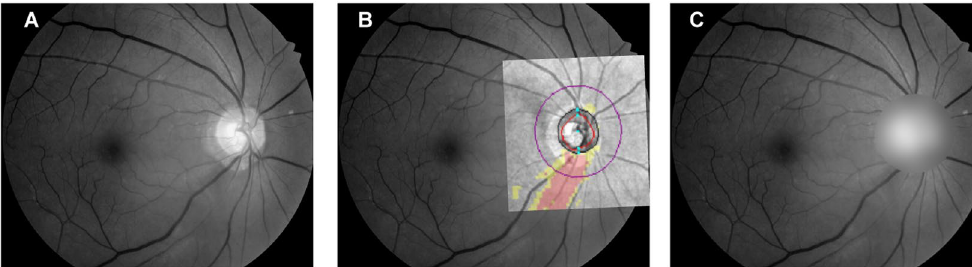
Figure 7. Example of peripapillary area masking on red-free RNFL photograph (RNFLP) (identical case to Fig. 5A). (A) Digital RNFLP. (B) RNFL deviation map/RNFLP overlay image with black line delineating optic disc boundary as defined by SD-OCT. (C) After best circle fitting by ImageJ software (National Institutes of Health), the circular area (diameter: 1.5 DD) was masked using the Gaussian blur function. (RNFL = retinal nerve fiber layer; SD-OCT = spectral domain-optical coherence tomography; DD = disc